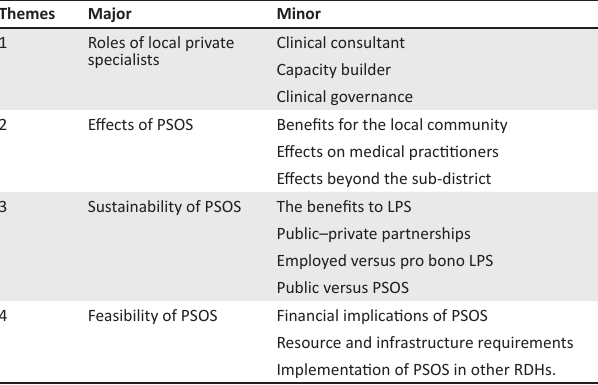
TABLE 2: The major and minor